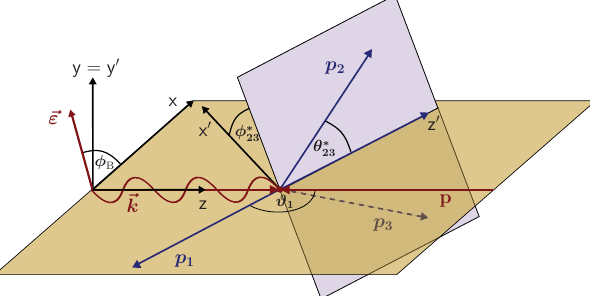
Figure 2. Kinematics of the 3-body final state, showing the reac- tion plane spanned by the incoming photon and one of the final state particles ( p 1 ) and the decay plane spanned by the remaining final state particles ( p 2 and p 3 ). For the p π 0 π 0 final state there are two choices for particles 1(23): p( π 0 π 0 ) and π 0 (p π 0 ).